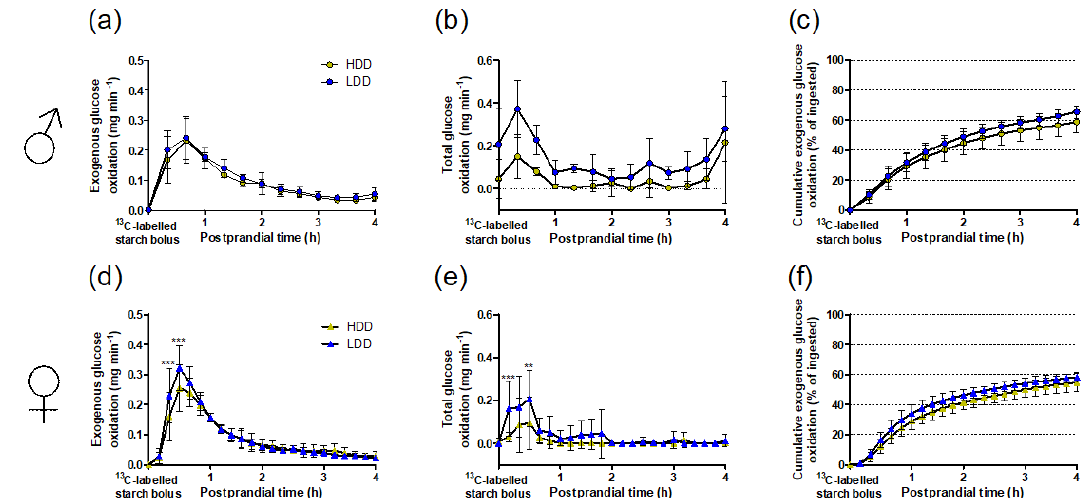
Figure 3. Glucose oxidation kinetics after oral administration of a 13 C-labelled starch bolus to HDD and LDD mice in PW 4. ( a,d ) Instantaneous starch-derived glucose oxidation rate. ( b,e ) Total glucose oxidation rate. ( c , f ) Cumulative starch-derived glucose oxidation. ( a – c ) Males ( n = 5), ( d – f ) females ( n = 6). Data are presented as mean and SD. Bonferroni’s post hoc test for multiple comparisons, ** P < 0.01, *** P < 0.001. HDD, highly digestible-starch diet; LDD, lowly digestible-starch diet; PW, post-weaning week.